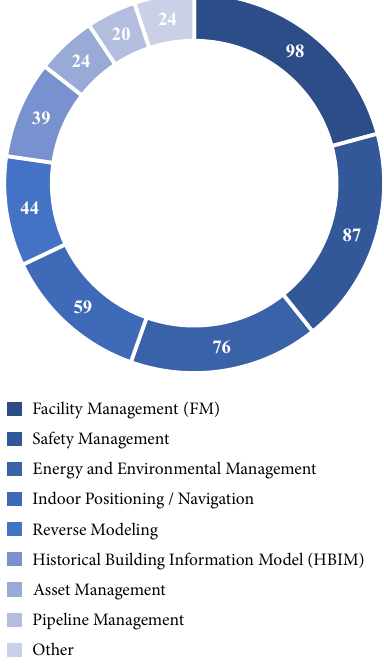
Figure 9. Distribution of BIM use at the operation and maintenance